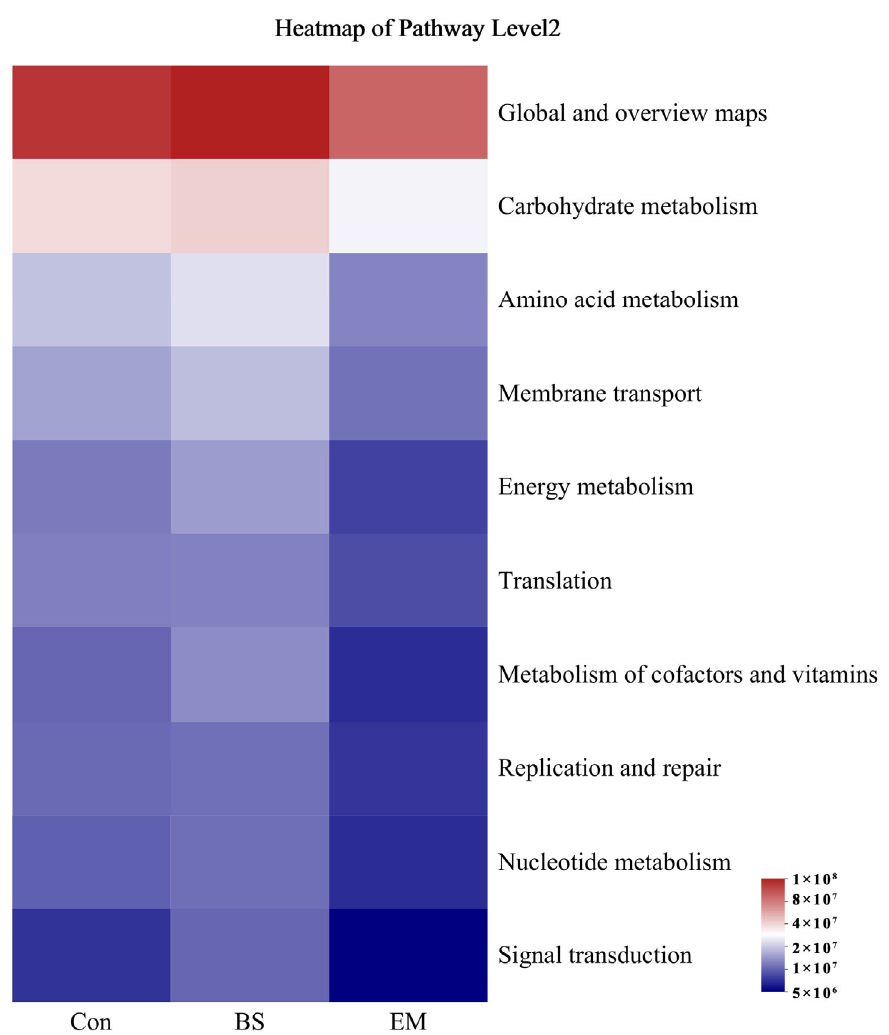
Figure 6. Functional prediction of the intestine microbiome of M. rosenbergii .